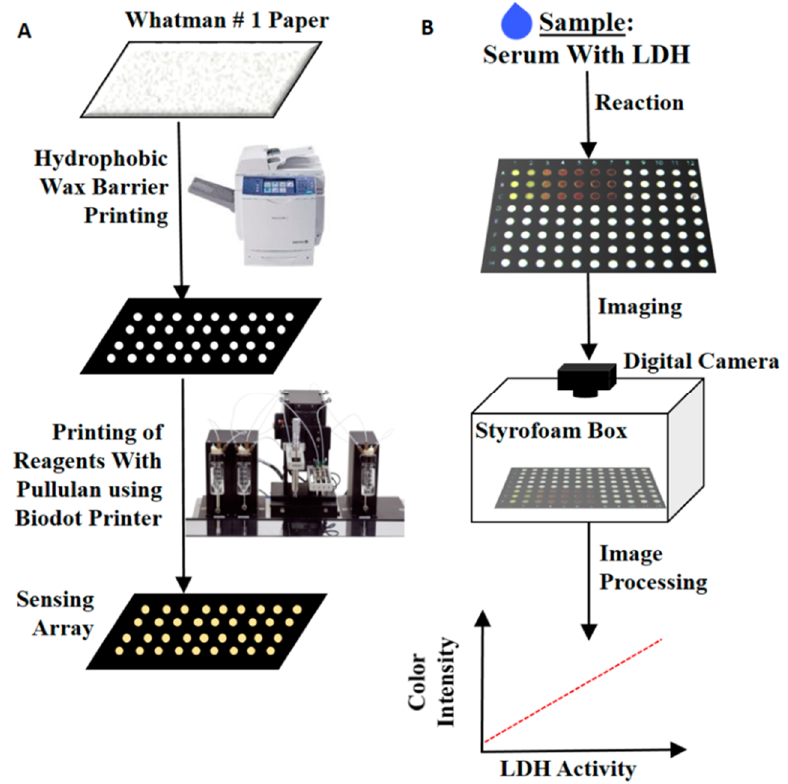
Figure 3. ( A ) Preparation of paper-based LDH sensors. ( B ) Assay for serum LDH [98]. Copyright 2015 American Chemical Society.